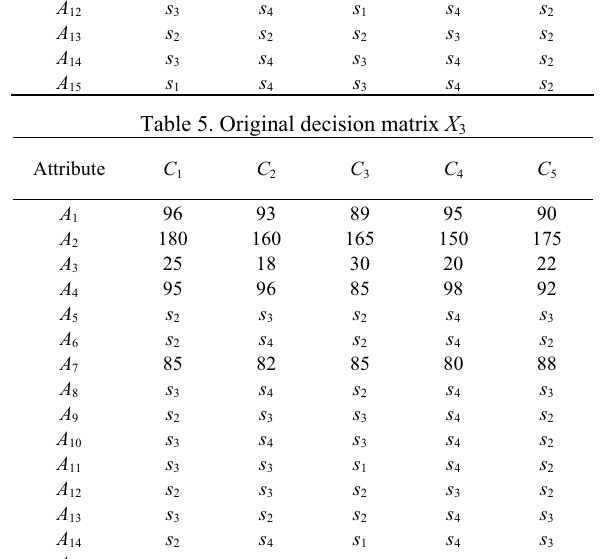
Table 8. Decision matrix Y